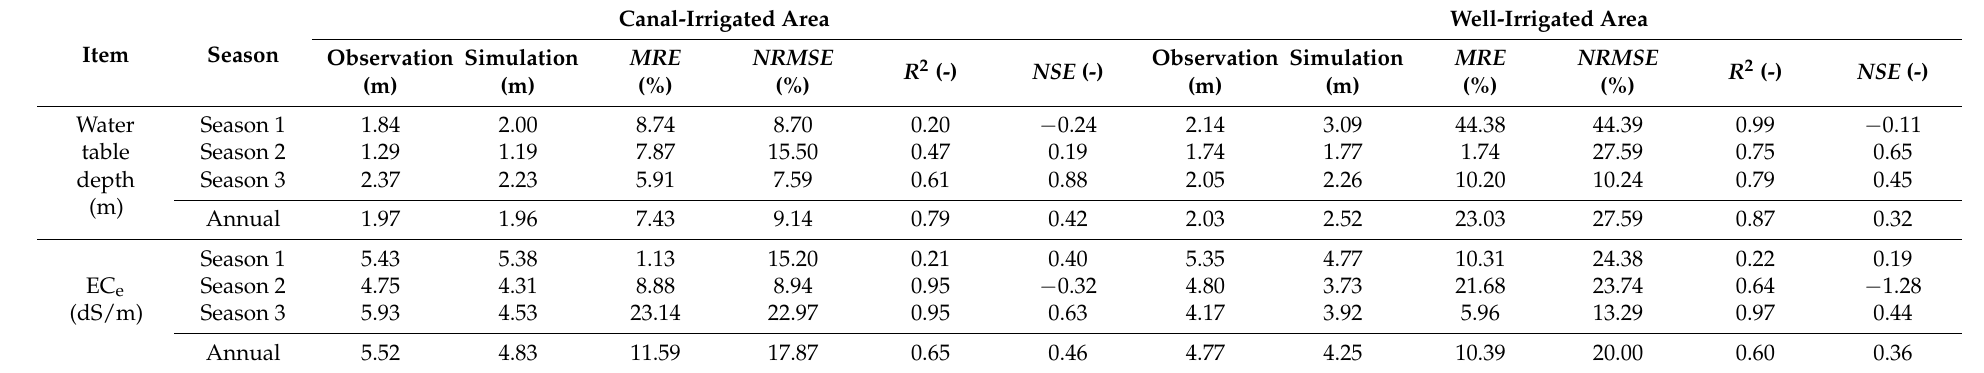
Table 4. Model calibration results obtained by comparing the simulated and measured water table depths and root zone soil salinities.